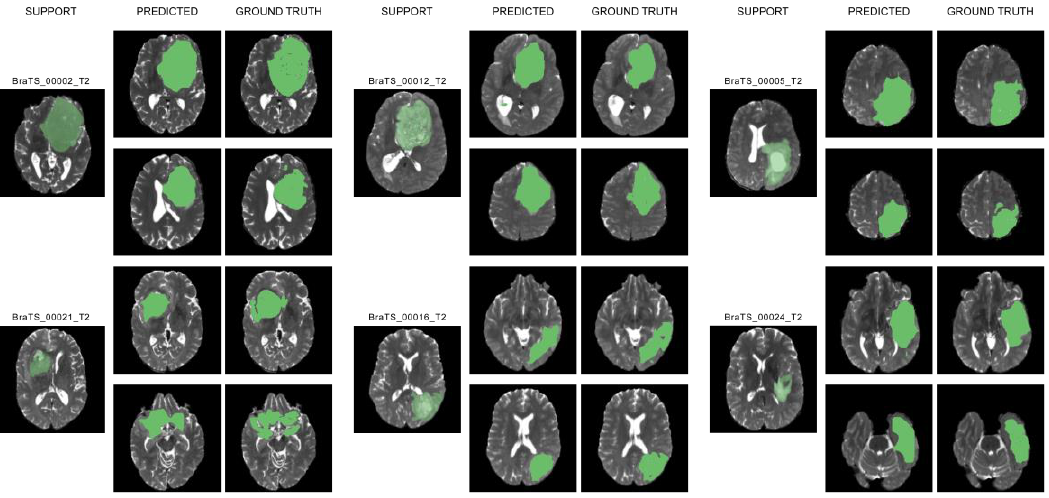
Figure 4. Qualitative results of our model with different support sets on two slices of different query images along with their ground truths. In these figures, tumor regions are depicted in green. The proposed learning method achieves desirable segmentation results which can be verified with their corresponding ground truth images.